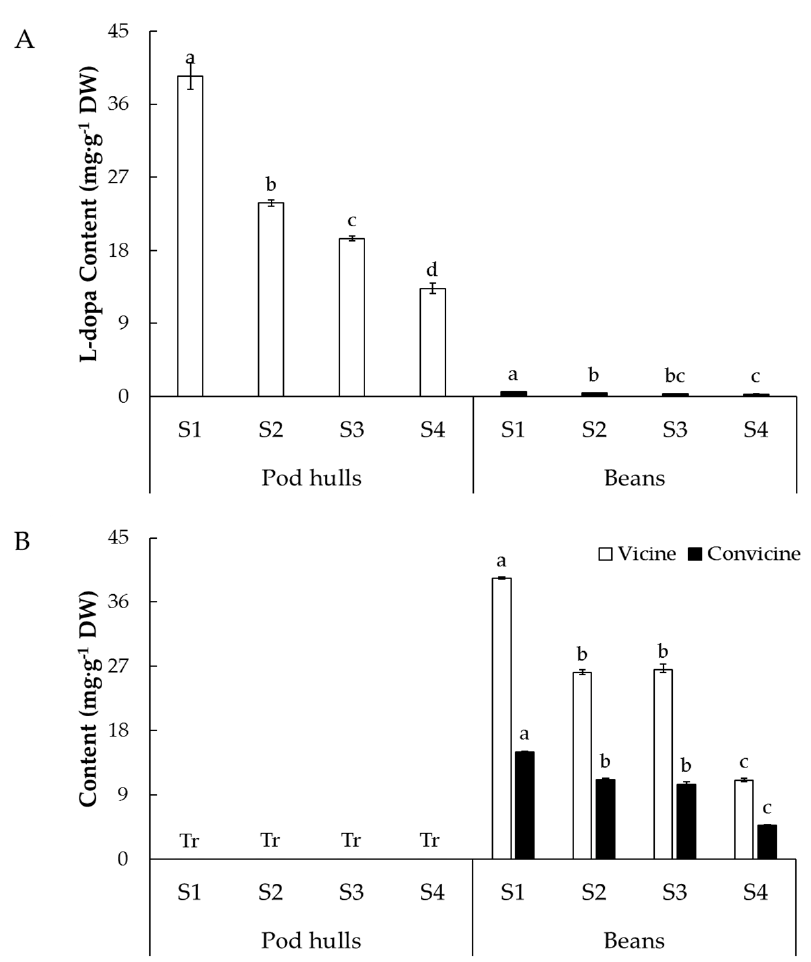
Figure 5. Contents of ( A ) L-dopa and ( B ) vicine and convicine in pod hulls and beans at different development stages. DW, dry weight. Tr, trace amount. Different letters within the same color column indicate significant differences at p < 0.05 (Tukey’s HSD test). Table 2. L-dopa, vicine, and convicine contents in stems and roots during the four growth stages of faba bean plants.